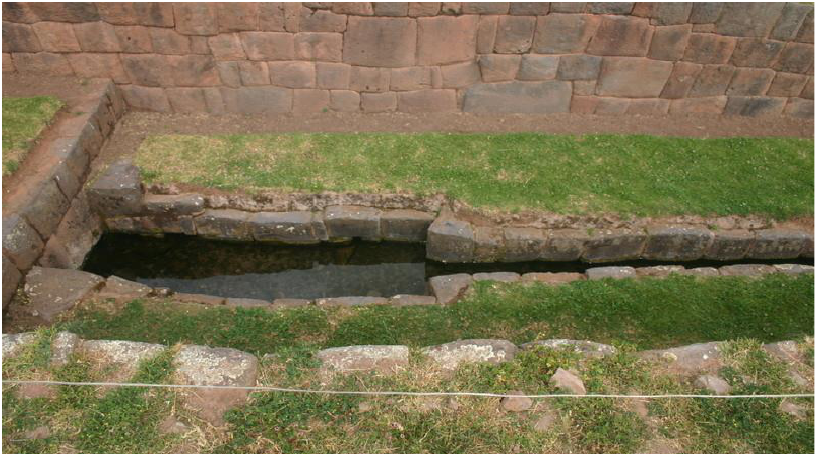
Figure 66. Channel cross-section geometry change made to induce critical flow in the contracted channel section to downstream channels supplying the Figure 67 Waterfall. Photo by author.